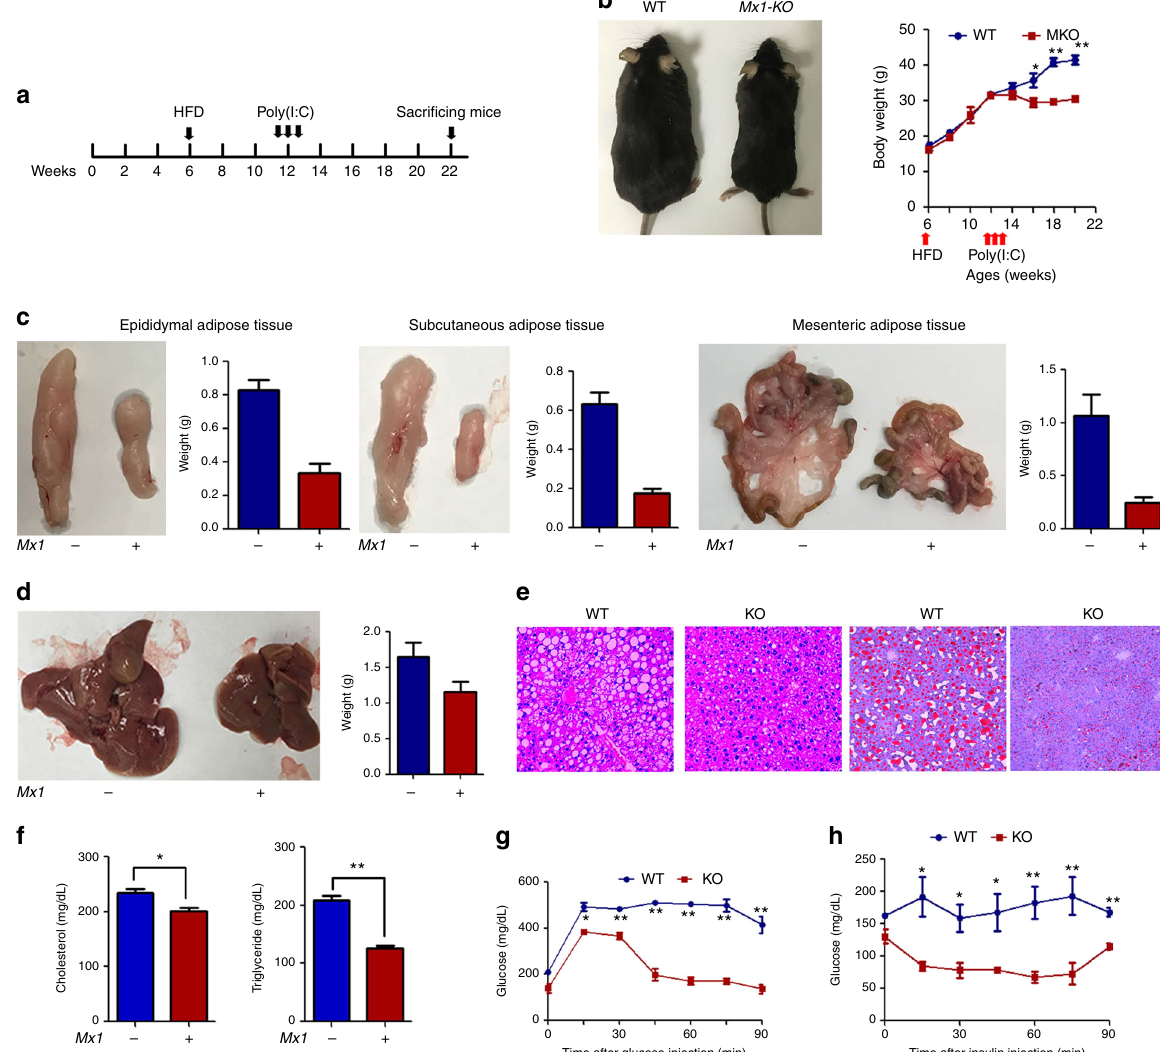
Fig. 7 HRD1 is a potential therapeutic target for HFD-induced obesity and fatty liver disease. a Flowchart of the study design. b Body weights of male mice were measured every 2 weeks while on a HFD. Fat ( c ) and liver ( n = 5 for each group) ( d ) weights from WT and polyI:C-injected HRD1 F/F Mx1-Cre + mice fed a HFD for 16 weeks. ( n = 5 for each group). e H&E and Oil Red O staining of the liver from c . f Serum TG and cholesterol levels from WT and polyI:C- injected HRD1 F/F Mx1-Cre + mice fed with 16 weeks HFD under the refed condition. Glucose tolerance assay ( n = 5 for each group) ( g ) and insulin tolerance assay ( n = 5 for each group) ( h ) were performed on mice after 16 weeks of HFD. Data are representative of three independent experiments (mean ± s.d.). * P < 0.05. ** P < 0.01 by unpaired Student ’ s t